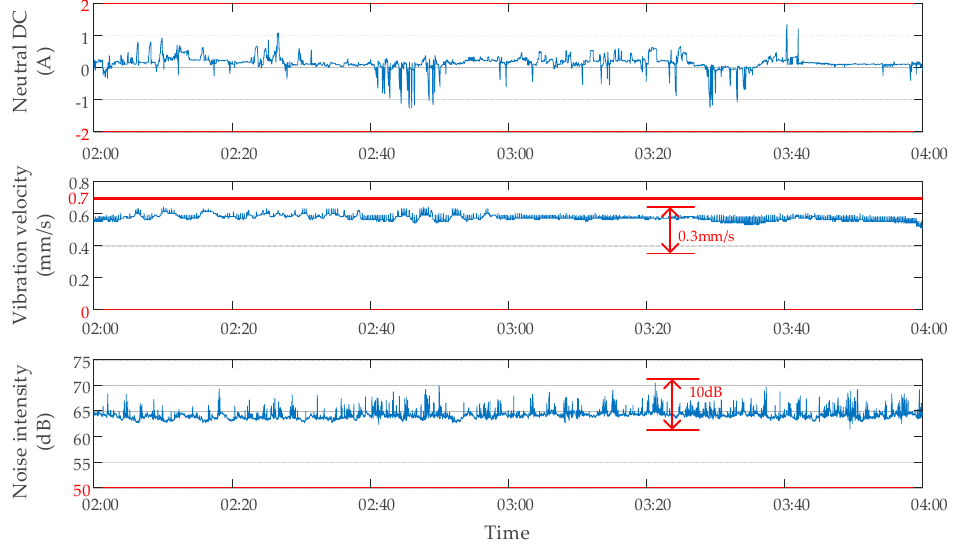
Figure 5. Data characteristics of a transformer without DC bias. Sensors 2020 , 20 , x FOR PEER REVIEW